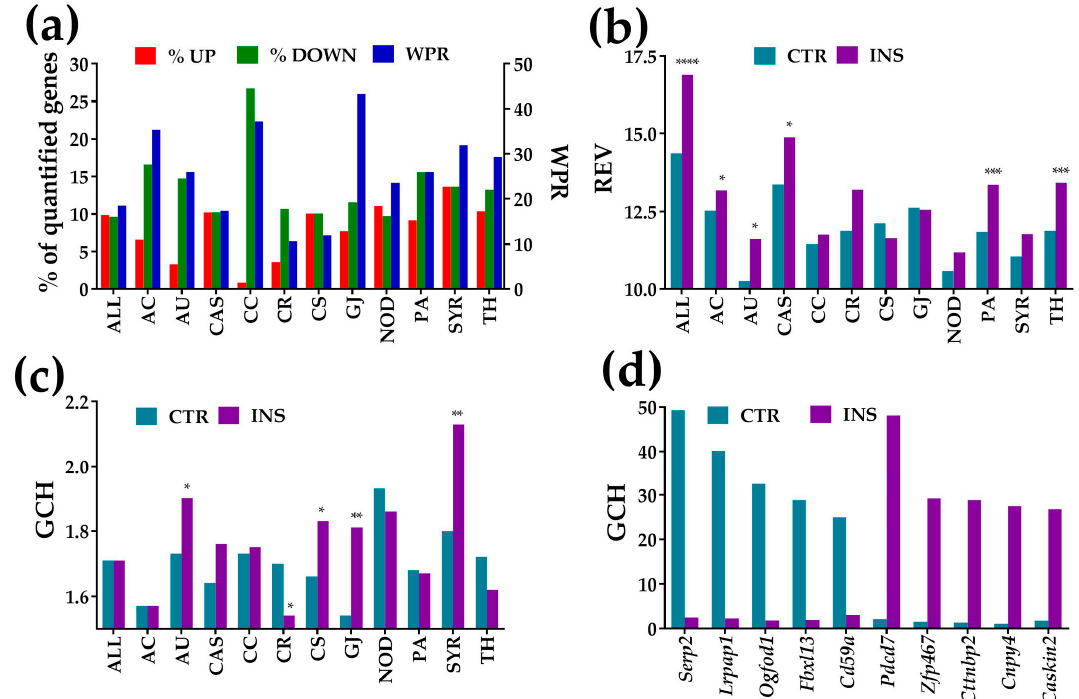
Figure 1. Alterations of the expression level, expression variability, and gene commanding height for all 18,891 quantified unigenes (ALL) and selected functional pathways and individual genes. ( a ) Percentages of significantly up / down-regulated genes and the Weighted Pathway Regulation (WPR) score of the selected pathways in astrocyte co-cultured with Oli neu cells (INS) with respect to astrocytes cultured alone (CTR). ( b ) Median Relative Expression Variability (REV) of selected gene groups in each condition. ( c ) Median Gene Commanding Height (GCH) of selected gene groups in each condition. ( d ) Top 5 genes (highest GCH scores) in each condition and their GCHs in the other condition.